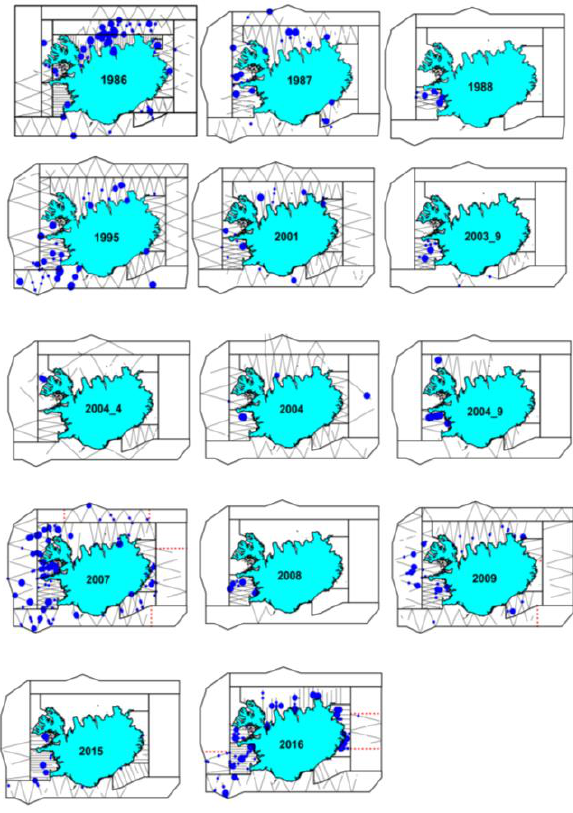
Figure 7. Realized survey effort and sightings of harbour porpoises by survey. Survey month is appended to year (numerical) if not June or July. No harbour porpoises were seen in the survey conducted in 2003_5. Symbol sized varies with group size from 1 to 3. Post-stratification borders are shown as red dotted